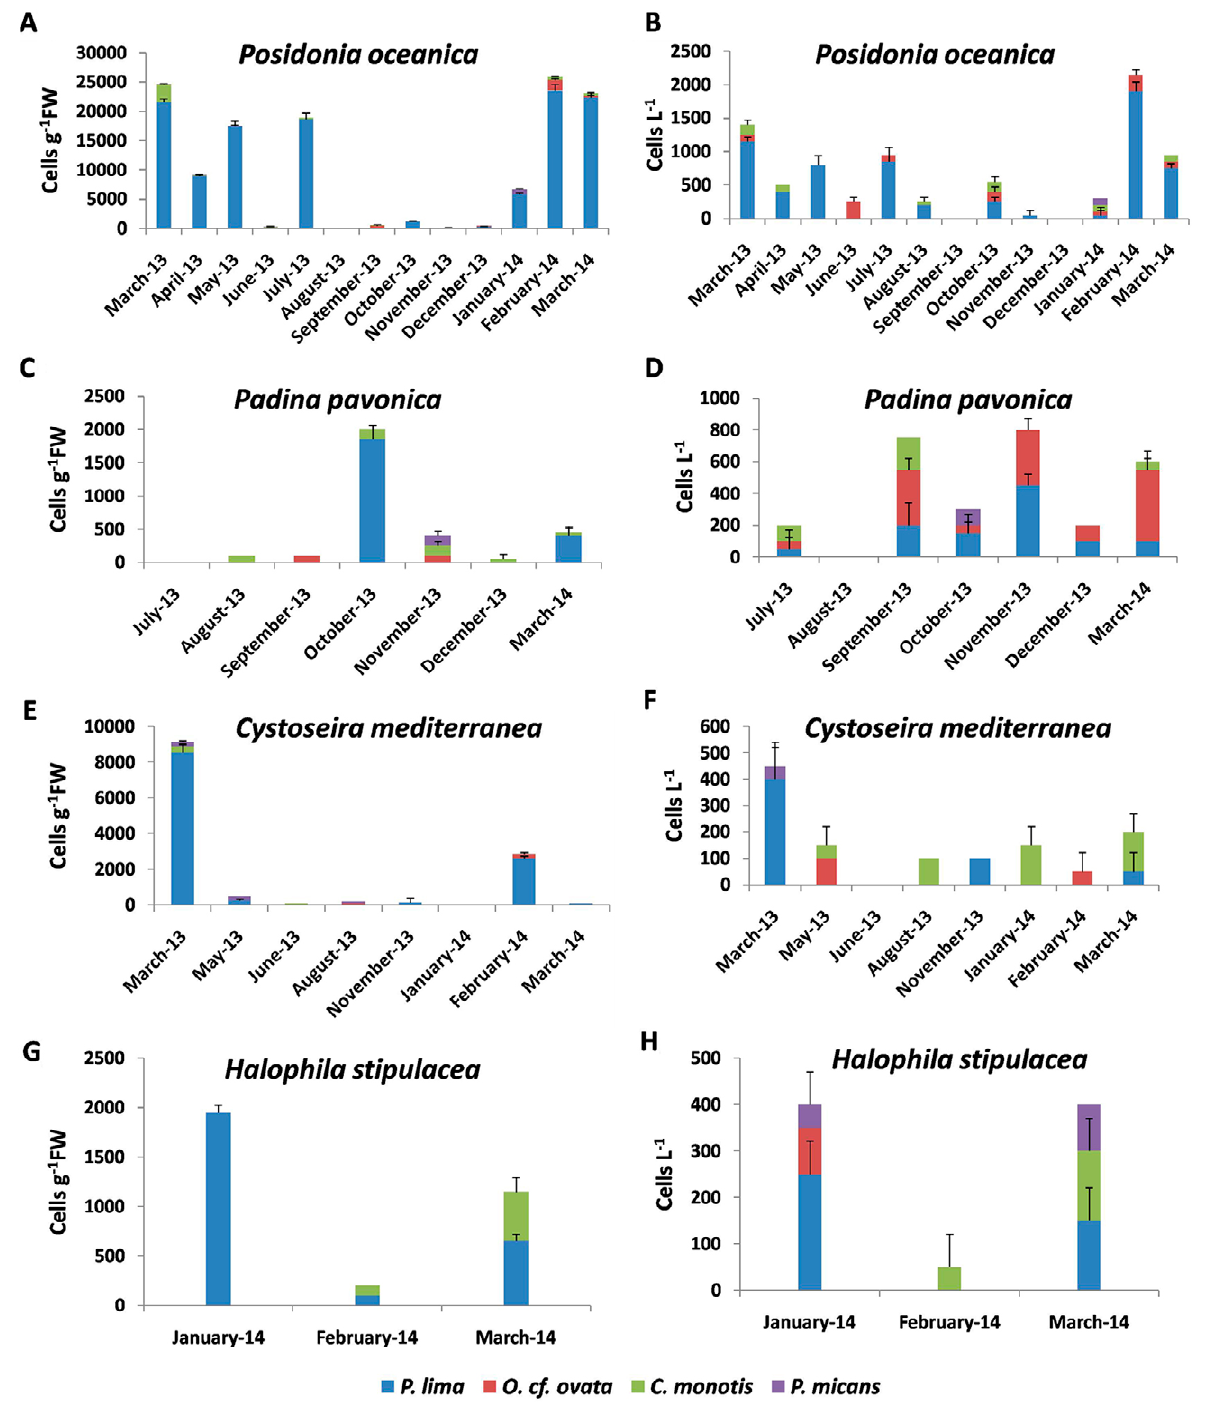
Fig. 3. – Temporal distribution of epibenthic toxic dinoflagellates on the coasts of Chebba. Left, epiphytic dinoflagellates; right, dinoflagel- lates in water